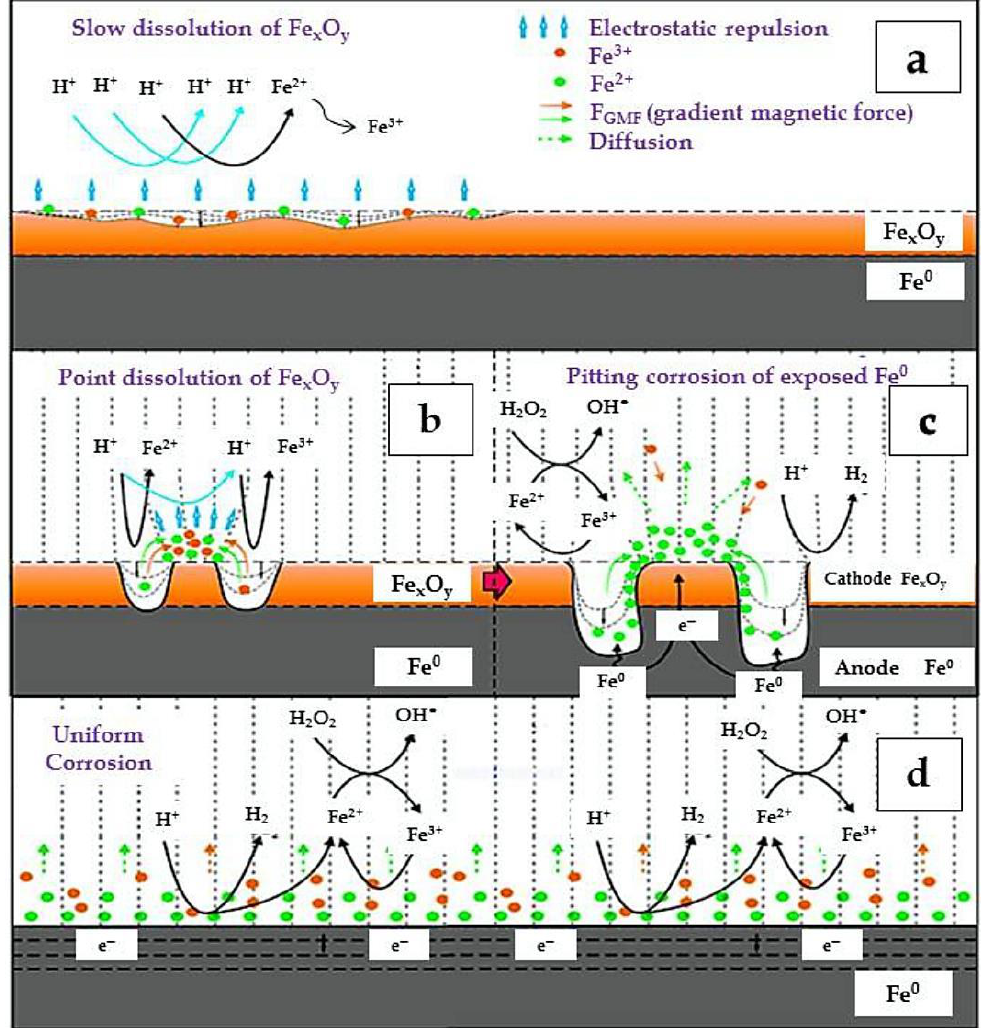
Figure 2. Schematic of a typical MF-ZVI-Fenton system. ( a ): Slow Fe x O y dissolution in the ZVI-Fenton system; ( b ): rapid point dissolution of Fe x O y in the presence of magnetic field followed by ( c ): pitting corrosion of the exposed Fe 0 sites and ( d ): uniform corrosion of the ZVI surface. Reproduced with permission from Reference [97].